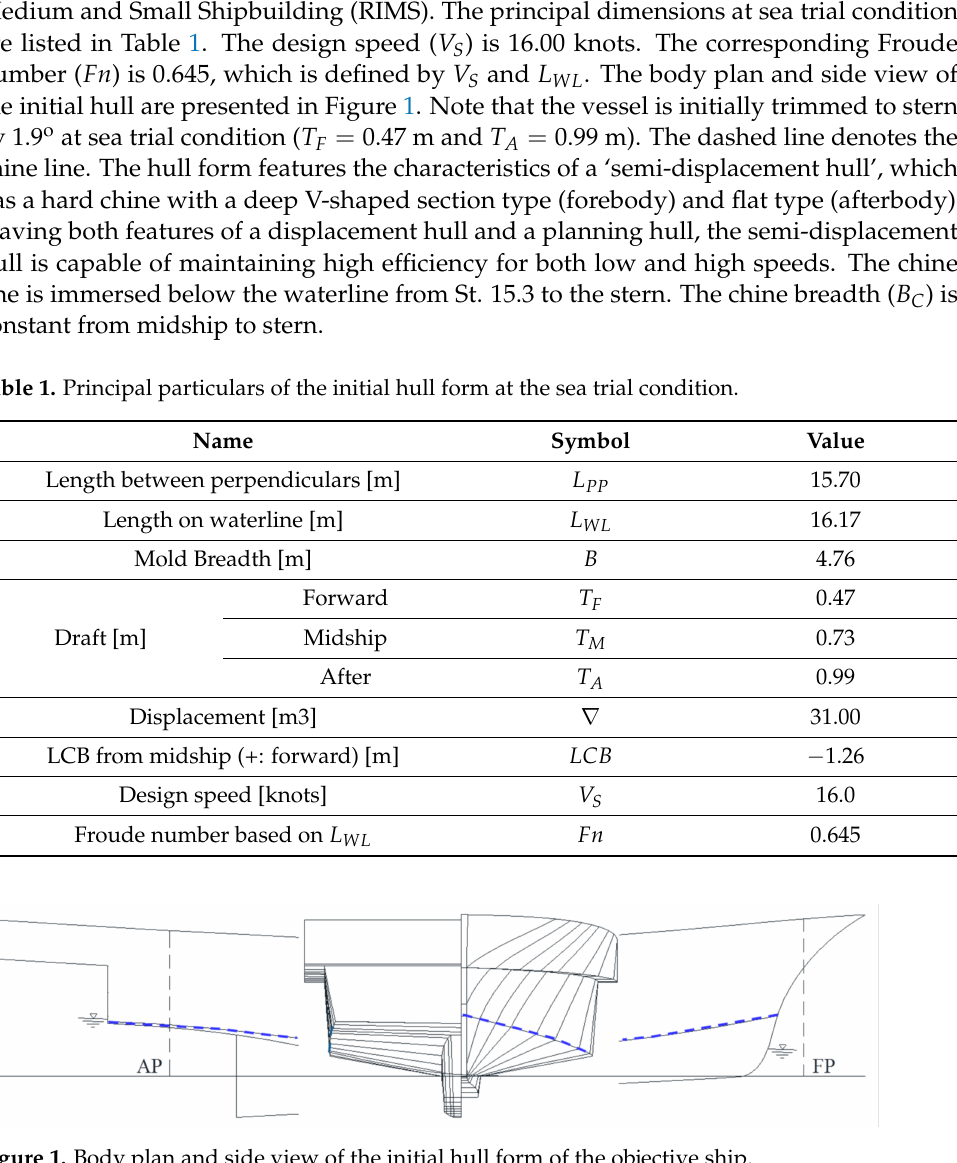
Figure 1. Body plan and side view of the initial hull form of the objective